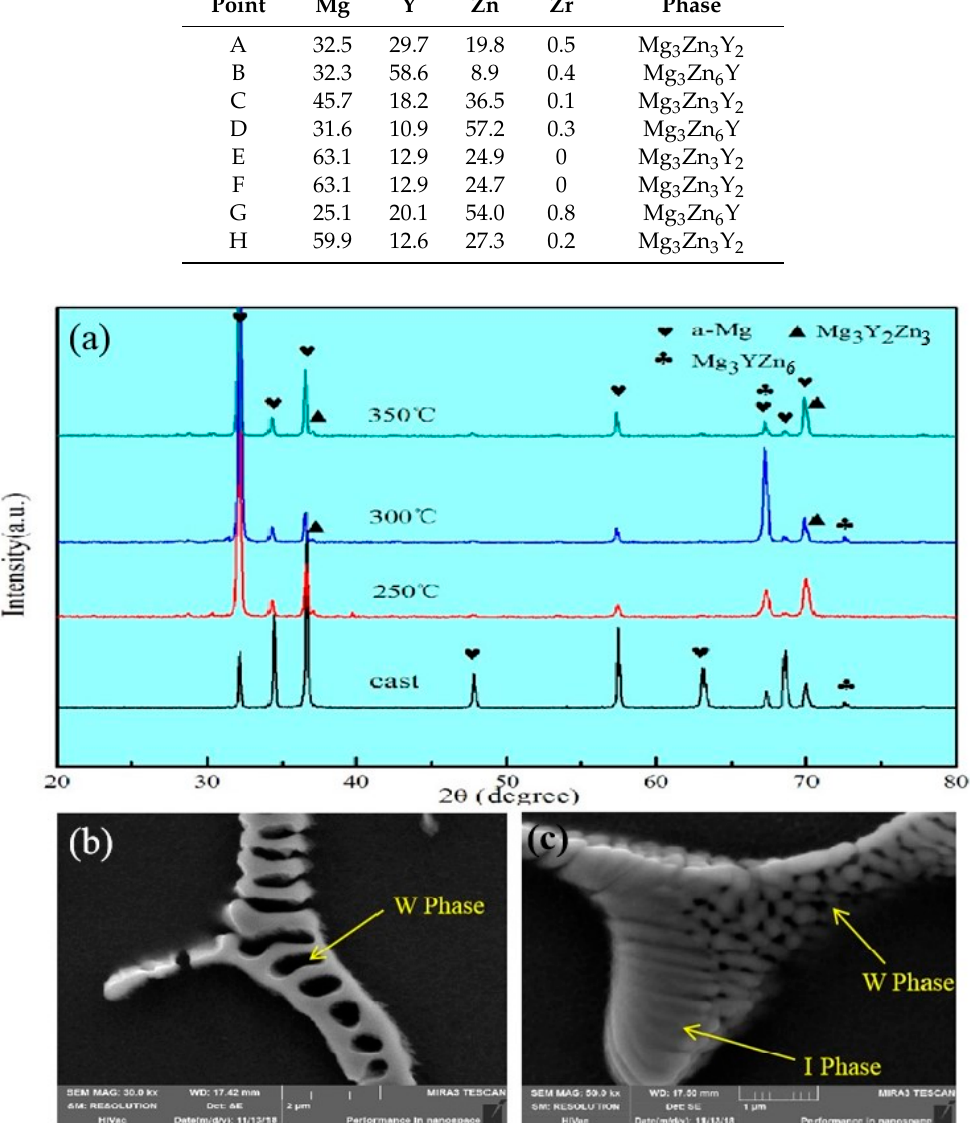
Table 1. The EDS analysis of second phase in the as-cast and as-extruded alloys.